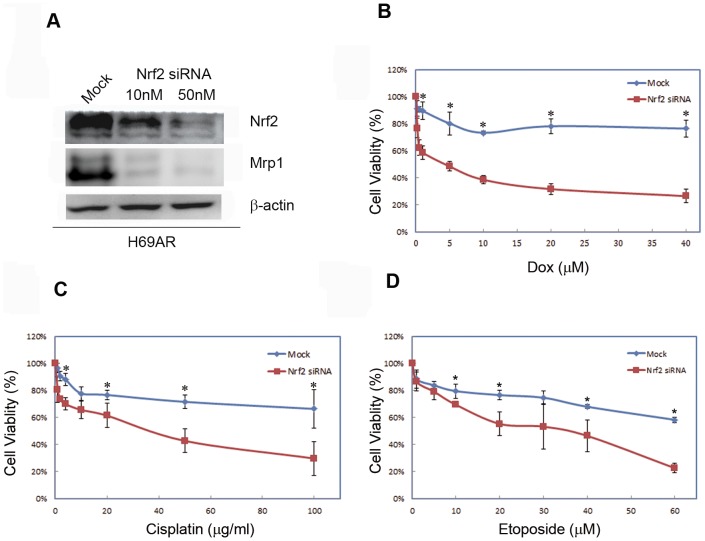
Down regulation of Nrf2 leads to decreased Mrp1 and sensitized H69AR cells to chemotherapeutic drugs.(A) H69AR cells were performed transfection of Nrf2 siRNA (10 nM and 50 nM) for 72 hours. Protein expression of Nrf2 and Mrp1 was determined by western blotting using β-actin as internal control. Experiments were performed three times and a representative immunoblot was shown here. (B), (C) and (D) H69AR cells were subjected to knockdown of Nrf2 with siRNA transfection. Forty-eight hours later, cells were treated with Dox, Cisplatin and Etoposide in different doses for additional 24 hours, and they were then subjected to MTT assay to measure cell viability. The experimental differences were determined by two-tailed Student's t-test and p<0.05 was taken as a significant difference in all cases.